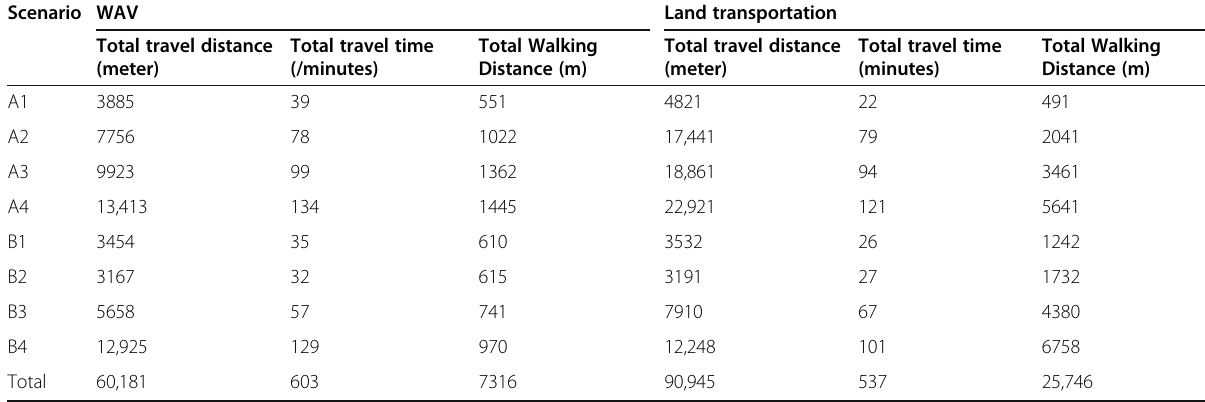
Table 3 Comparison of WAV and public